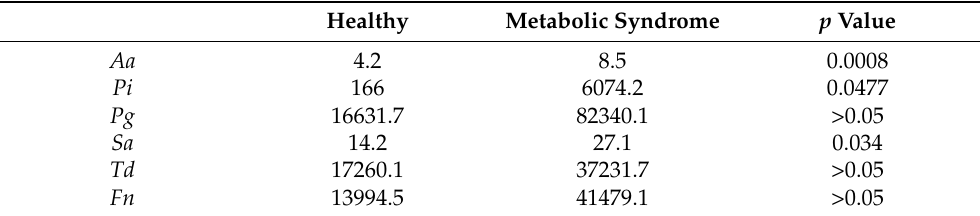
Table 3. Total bacterial counts dividing patients in groups by metabolic status (Metabolic syndrome vs.